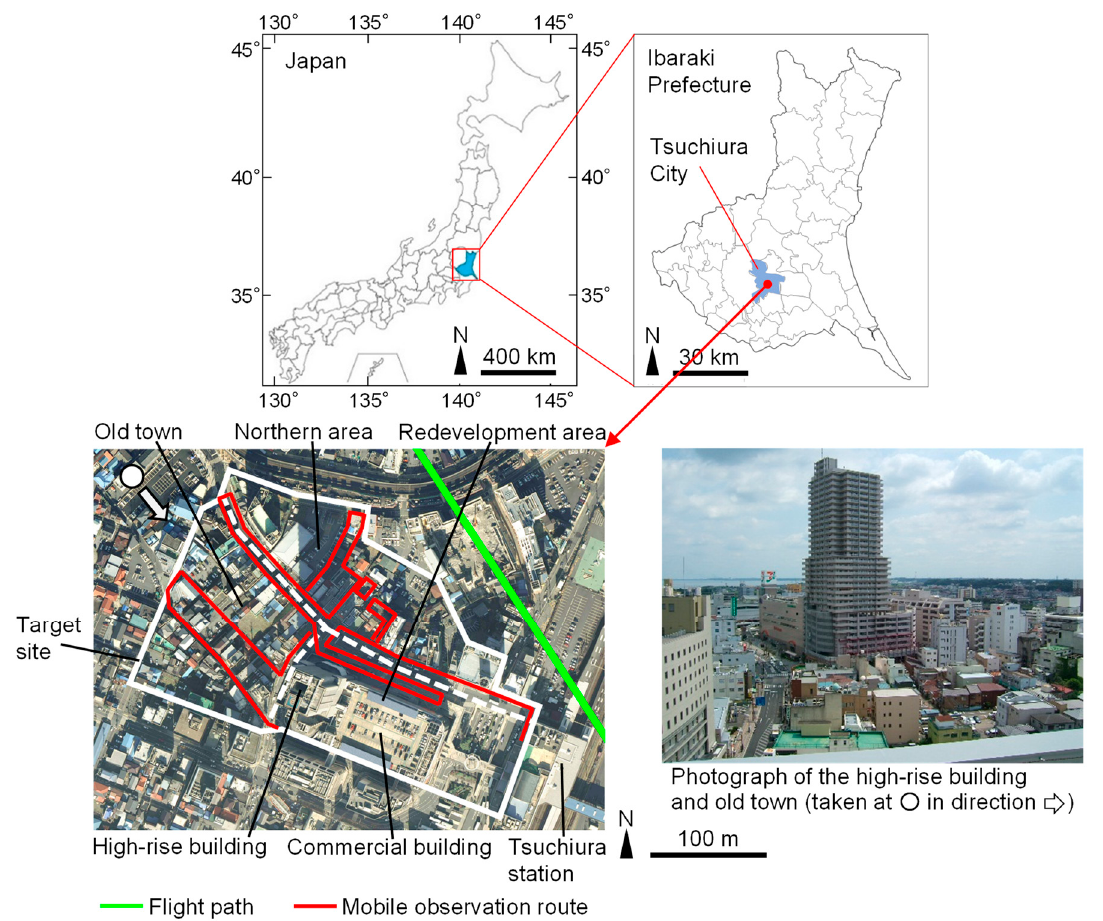
Figure 1. Location of the study site ( top ) and photographs of the study site ( bottom ), including the flight path of remote sensing and the mobile observation route.